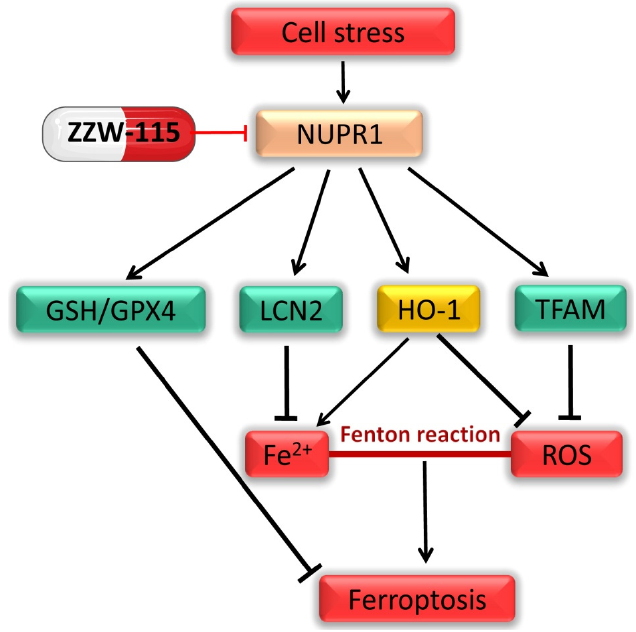
Figure 2. NUPR1 regulates ferroptosis via iron metabolism, ROS homeostasis and the GSH/GPX4 pathway.